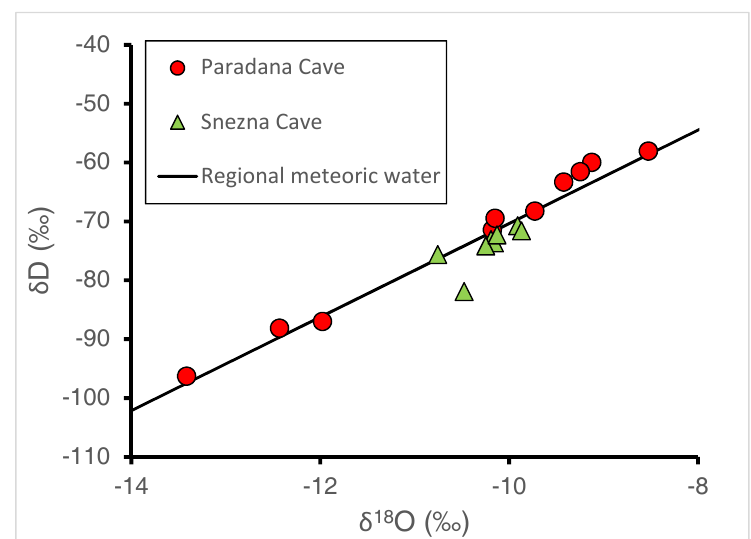
Figure 6. Plot of δ D and δ 18 O of ice samples from Paradana Cave and Snežna Cave plotted with the regional meteoric water line developed from GNIP samples collected in Ljubljana [20], Portorož [21], and Kozina [22].